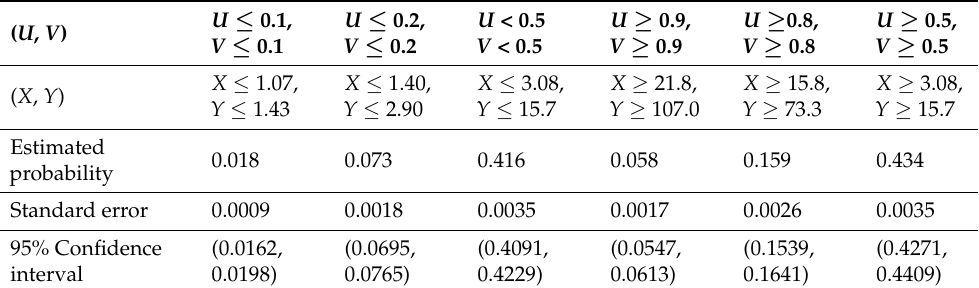
Table 3. The estimated probabilities, standard errors, and 95% confidence intervals of the random vector ( X , Y ), or ( U , V ), falling into different regions ( X denotes discharge and Y is precipitation, U and V are the standardized X and Y respectively, that is, U = ˆ F 1 ( X ) and X = ˆ F − 1 ( V ) Y = ˆ F − 1 2